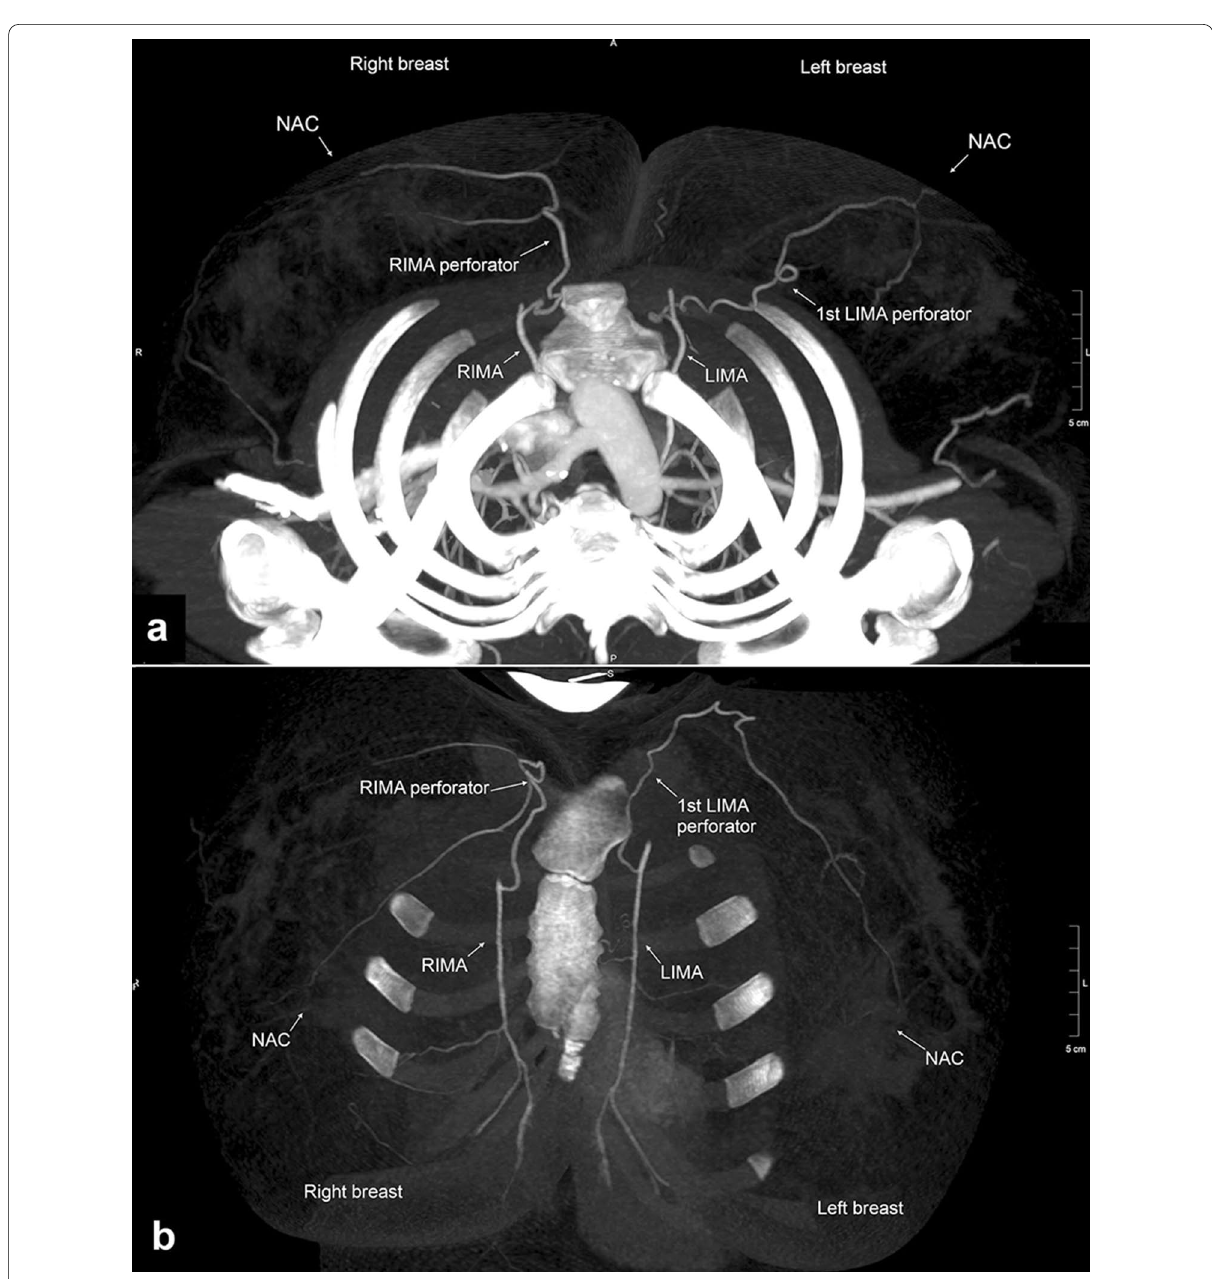
Fig. 1 Dominant internal mammary artery supply to NAC. Axial ( a ) and coronal ( b ) MIP images showing dominant right and left internal mammary arteries on both sides supplying sizeable perforator that reaches NAC on each